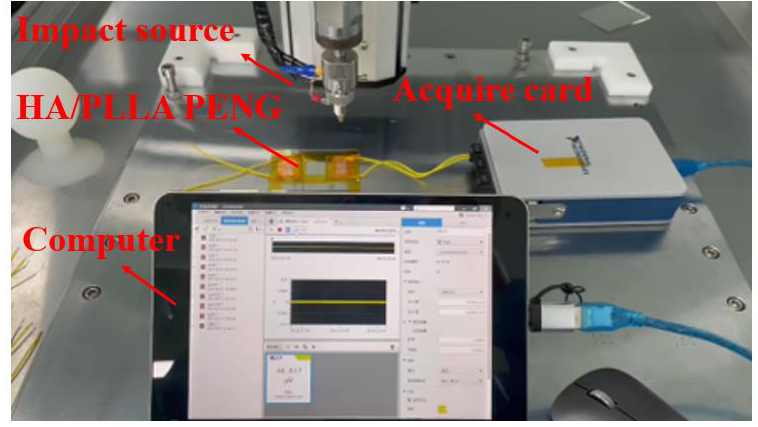
Figure 2. The evaluating system of PENG output performances.